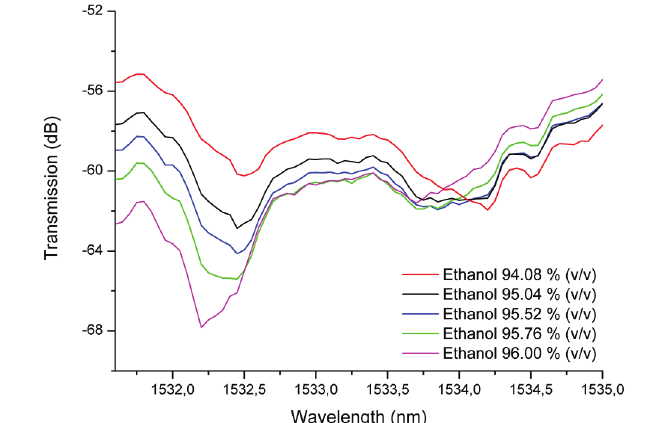
Figure 5 . Transmission spectra of the 1D photonic crystal microfluidic channel (eighteen pillars) for five different ethanol concentrations [96.00%, 95.76%, 95.52%, 95.04% and 94.08%